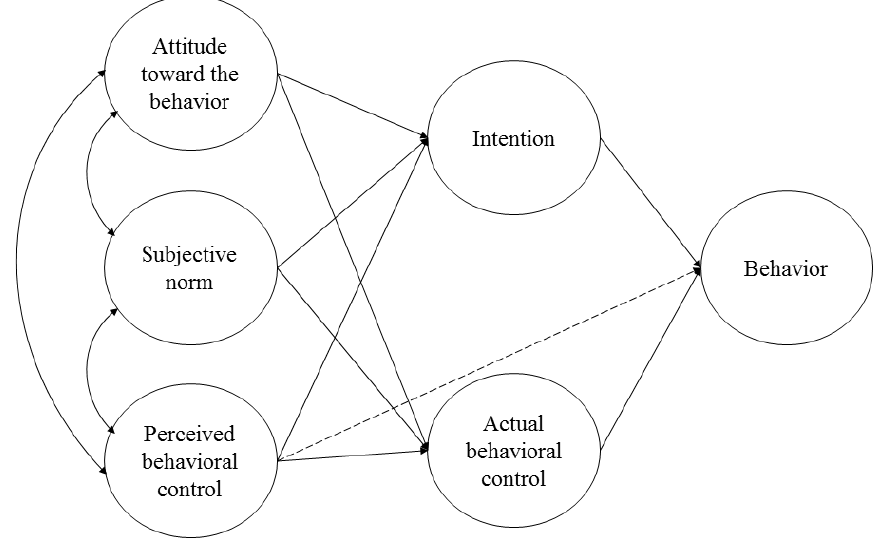
Figure 2. Theory of Planned Behavior Applied to a Drug Resistance Strategies Prevention Model (based on